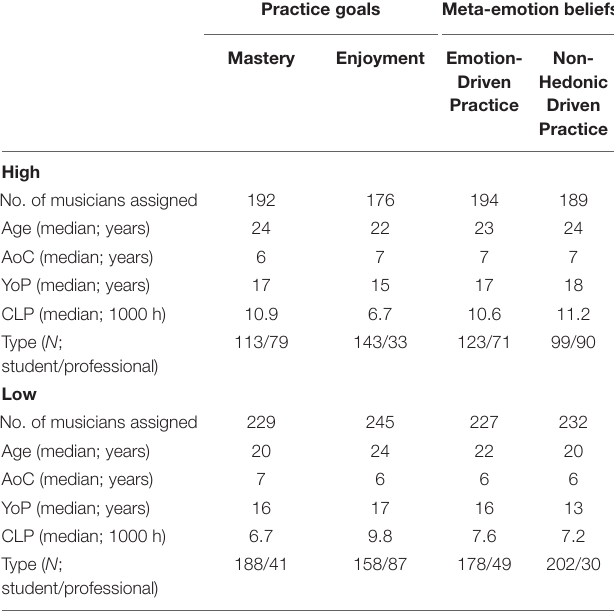
TABLE 4 | Overview of the quantity and characteristics of musicians classified into high/low categories for goals and emotion